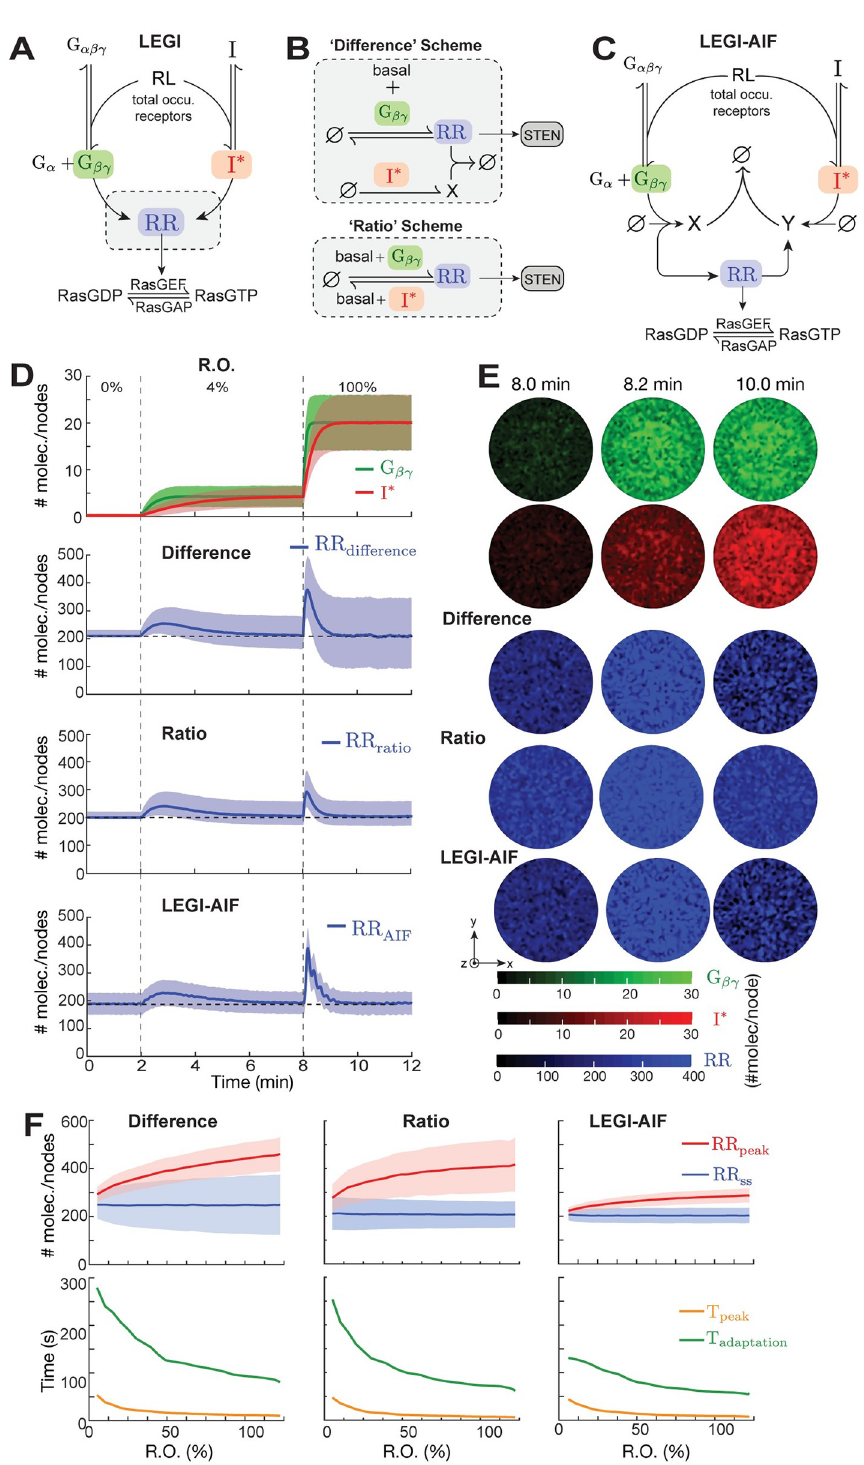
Fig 3. Response of the LEGI mechanism to global stimulation. (A) Output of receptor module, RL = H:C + L:C + S: C + P H:C + P L:C, drives the LEGI module. LEGI scheme involves a local activator (G βγ ) and global inhibitor (I ? ). Their interaction creates a response regulator (RR) which positively affects the conversion of RasGDP to RasGTP. (B) The regulation of RR can be realized either through a Difference scheme (top) or through a Ratio scheme (bottom). Both involve basal and G βγ -dependent production of RR. Whereas inactivation is mediated by I ? through an intermediate